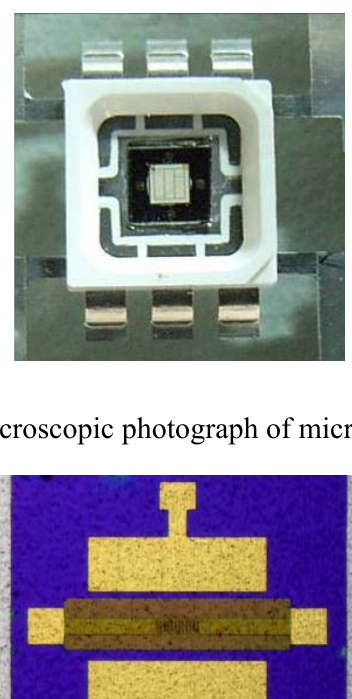
Figure 5. High-power LED with micro temperature sensor.